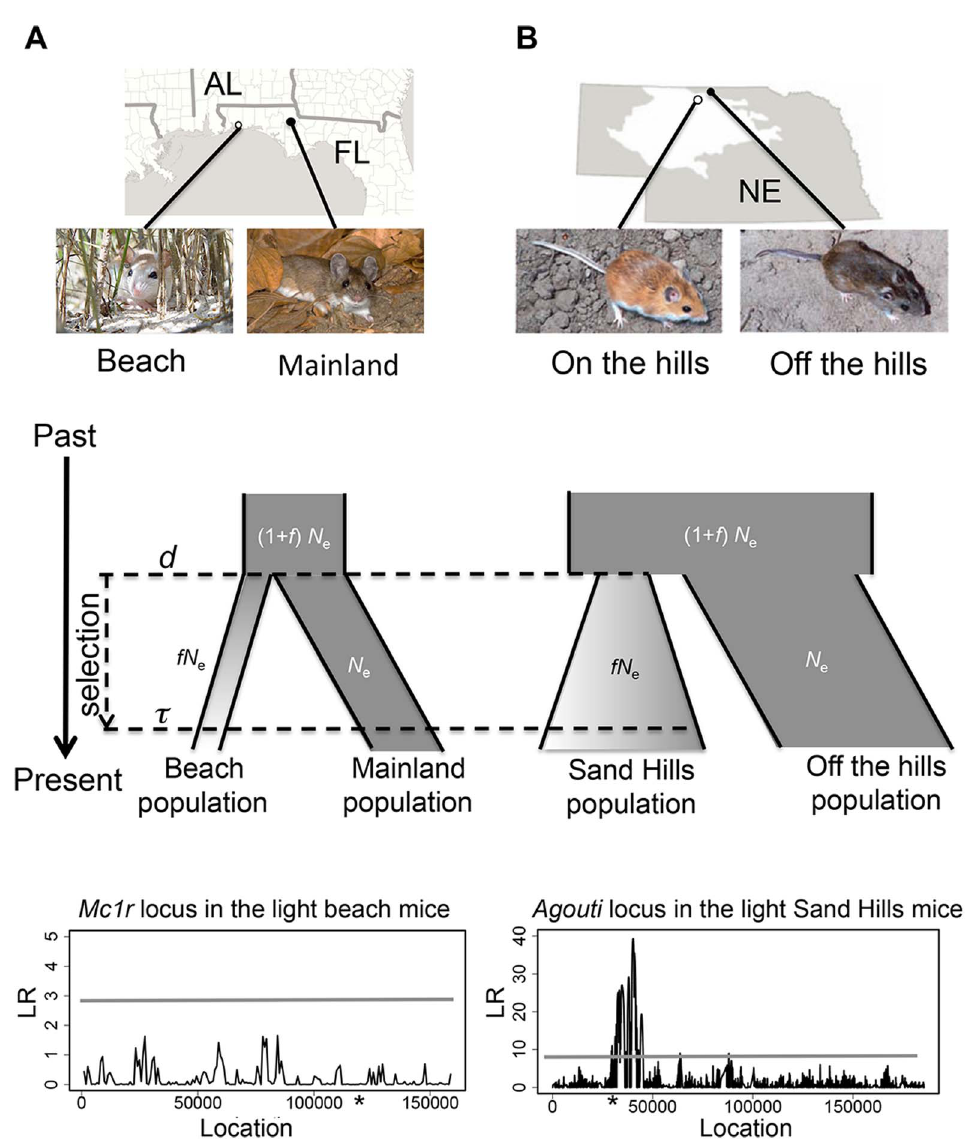
Figure 1. The inferred demographic history of the Florida and Nebraska populations. Geographic location and photos of the derived light and ancestral dark mouse populations from (A) Florida (photos by J. Miller and S. Carey) and (B) Nebraska (photos by C. Linnen) (top panel). Cartoon representation of the inferred demographic model of the two species (middle panel). Both models include selection acting on the bottlenecked population (with effective population size reduced to fN e , where N e is the ancestral population size) immediately after the divergence from the ancestral population at time d , and the selected allele becomes fixed at time t . Likelihood ratio (LR) profile of Sweepfinder in both populations of light-colored mice (bottom panel), where the horizontal line indicates the significance cutoff. Stars indicate the approximate location of causal mutations conferring light pigmentation. Because there are multiple Agouti alleles, we here polarize (into ‘‘light’’ or ‘‘dark’’ class) based on the SNP mostly strongly associated with pigment variation (as described in